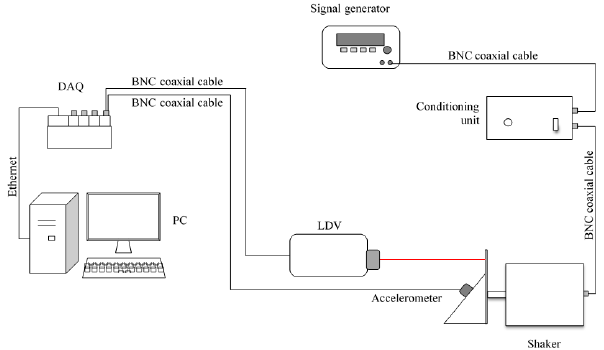
Figure 3. Scheme of the whole testing